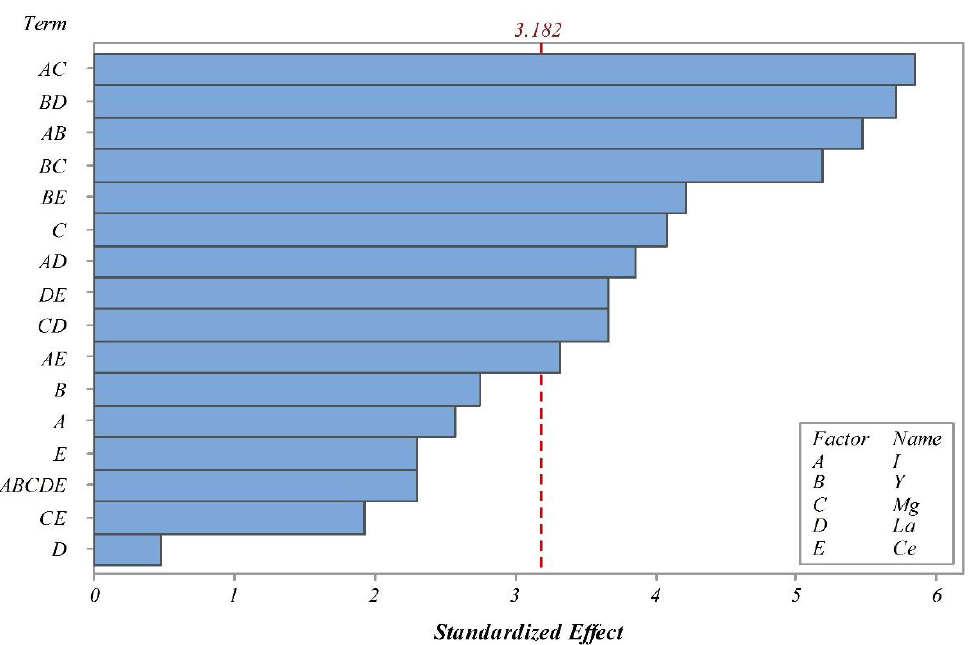
Fig. 5. Pareto plat of the standardized effects for Viscosity, α = 0.05.